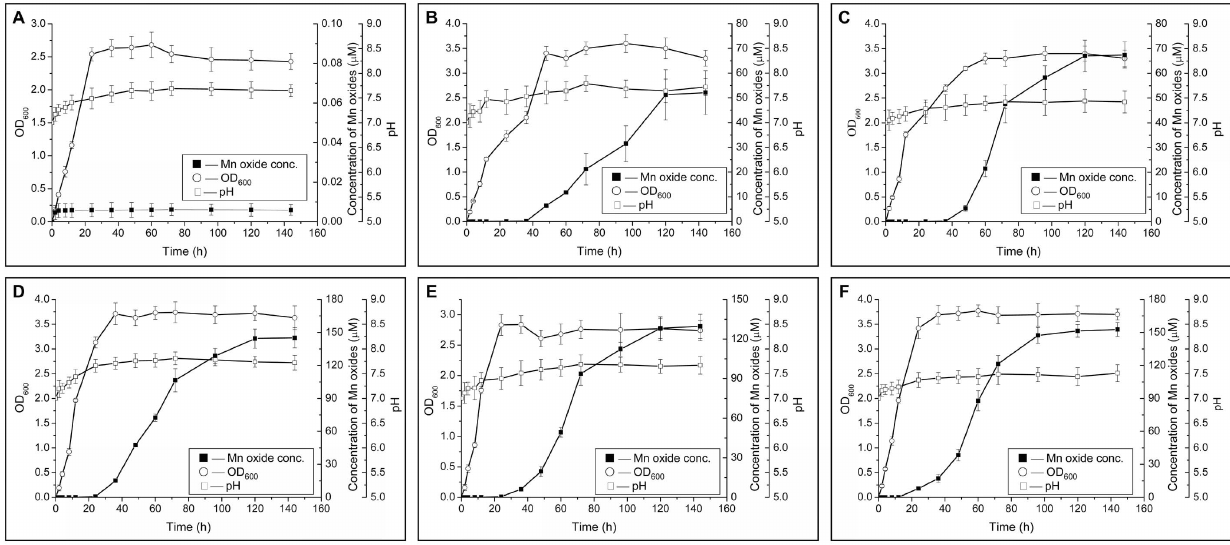
Figure 3. Time course of the Mn(II)-oxidizing activities and the cell growth of several isolates from A-, B-, and C-layer soils. The cells were grown in liquor K medium for 144 h. The absorbance (OD 600 ) and the concentration of Mn oxides were determined according to the procedures described in the ‘‘Materials and Methods’’ section. ( # ) Optical density of the cells (at 600 nm); ( & ) Concentration of Mn oxides; ( % ) pH. A: Non- Mn(II)-oxidizing E. coli JM109 (as the negative control). B : A86. C : A101. D : B84. E : C19. F : C13.